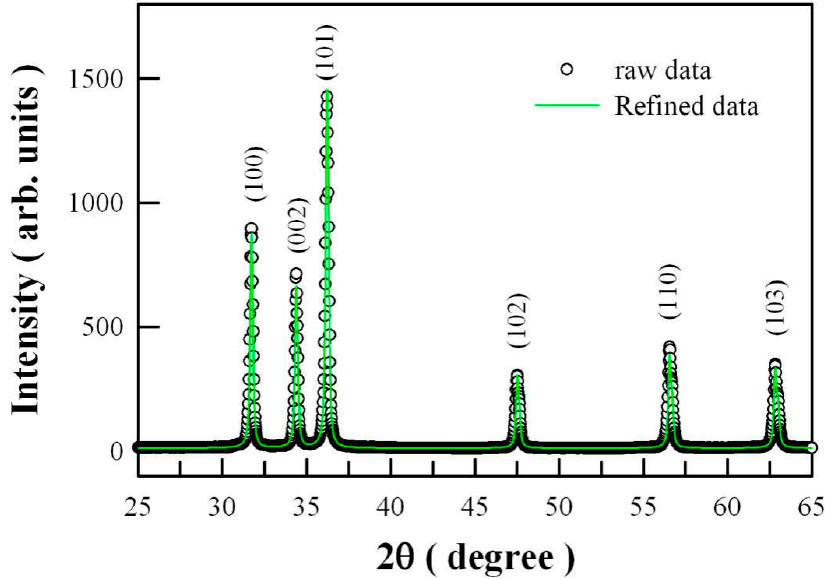
ff raction (XRD) curve of undoped ZnO nanocrystals and its Rietveld analysis. Catalysts 2020 , 10 , x FOR PEER REVIEW